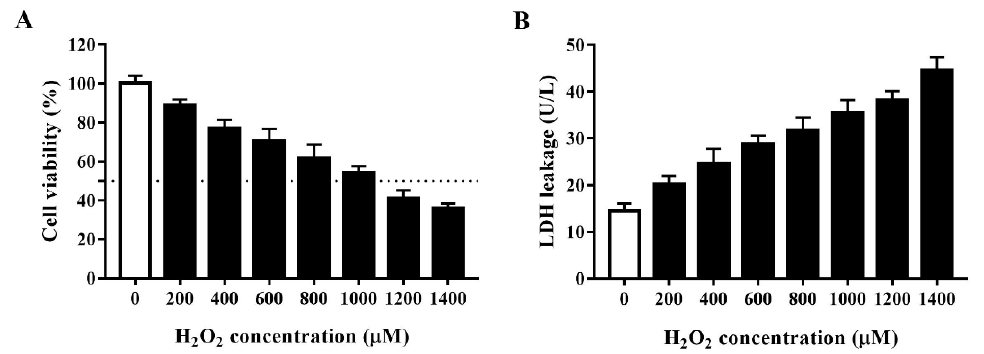
Figure 1. Establishment of an H 2 O 2 -induced oxidative stress model using IPEC-J2 cells. ( A ) Cell viability of IPEC-J2 cells after treatment with H 2 O 2 at different concentrations. IPEC-J2 cells were incubated with the indicated concentrations of H 2 O 2 for 4 h after which cell viability was measured using the cell counting kit (CCK)-8 assay. The black dotted line indicates 50% cell viability. ( B ) Lactate dehydrogenase (LDH) leakage from IPEC-J2 cells after treatment with H 2 O 2 at different concentrations. Culture supernatants were collected after cell treatment and LDH leakage was determined using an LDH assay kit.